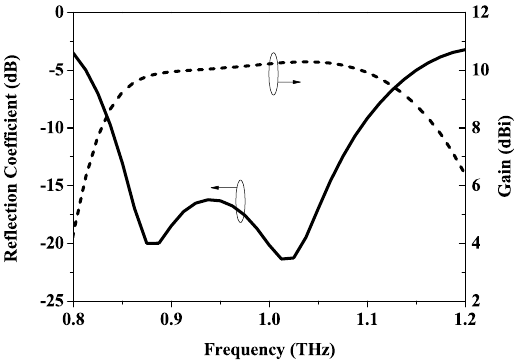
Figure 3. Simulated reflection coefficient and gain of the proposed antenna